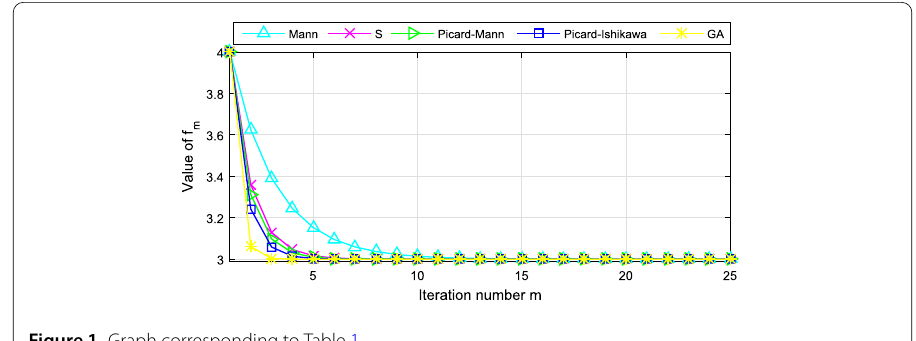
Figure 1 Graph corresponding to Table 1